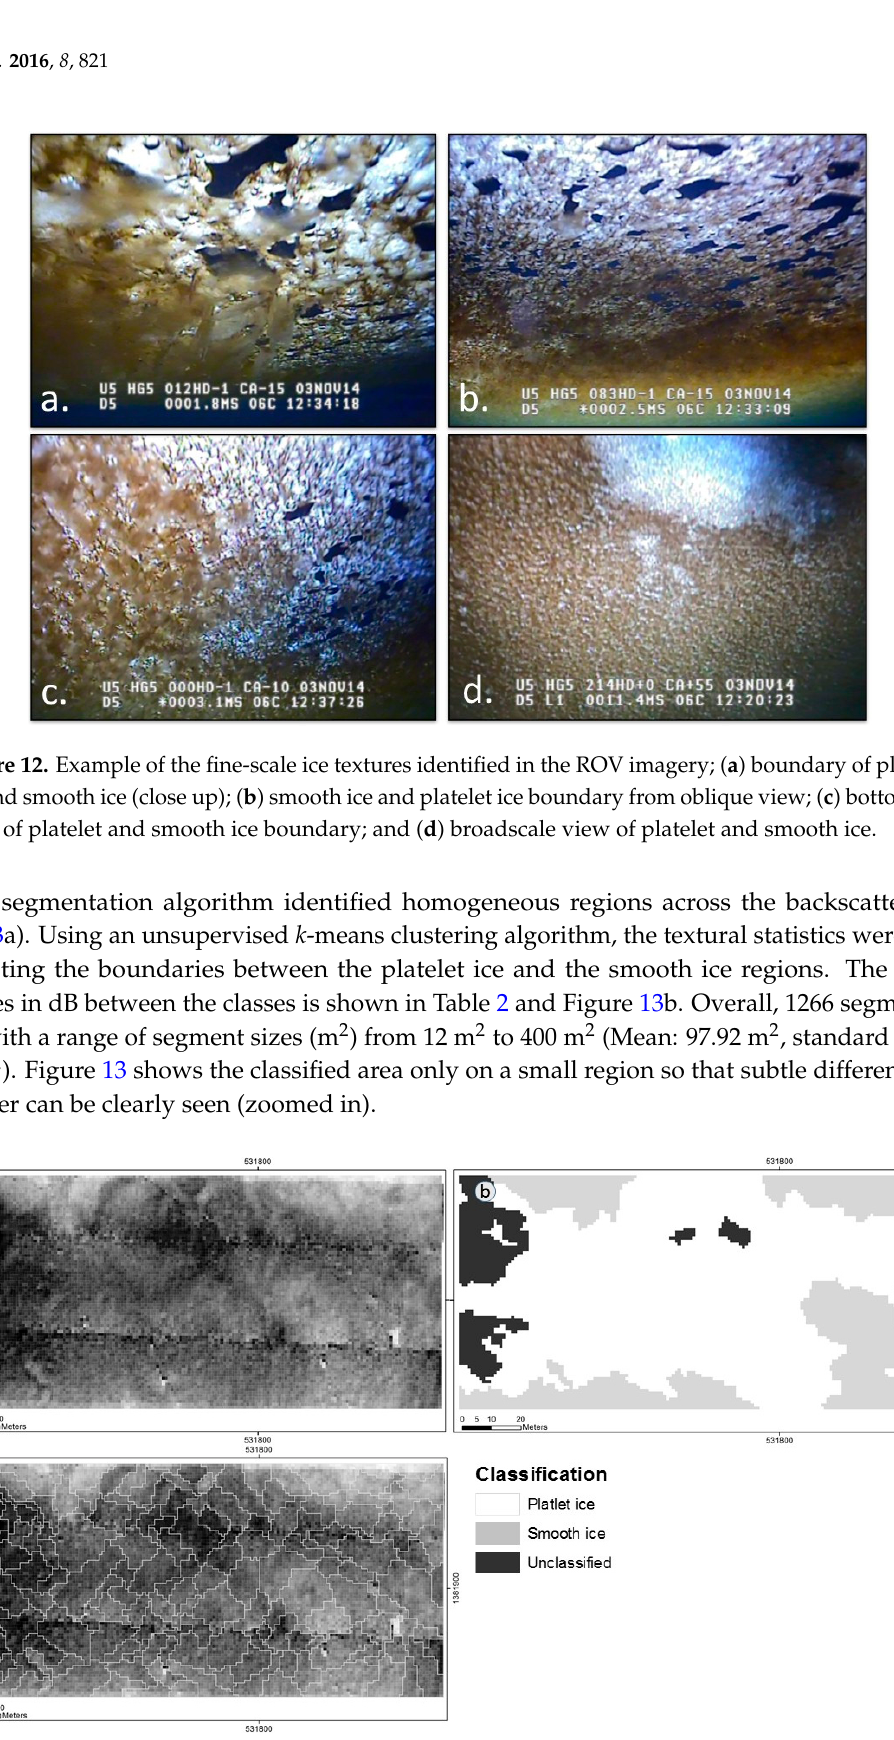
Figure 13. ( a ) Acoustic backscatter image processed at 5 cm resolution; ( b ) segmentation of the backscatter based on spectral statistics as outlined in Table 2; ( c ) classification of the ice surface into three classes platelet ice, smooth ice and unclassified.